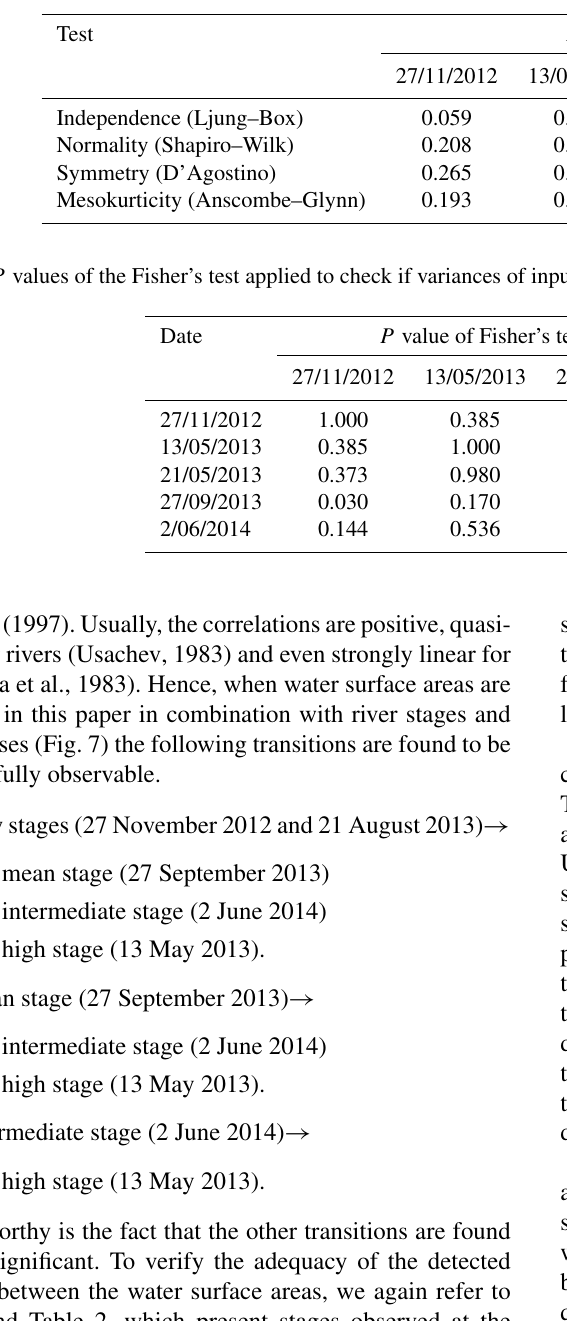
Table 4. P values of a few statistical tests applied to input data for the UAV flights on 27 November 2012, 13 May 2013, 21 August 2013, 27 September 2013 and 2 June 2014.